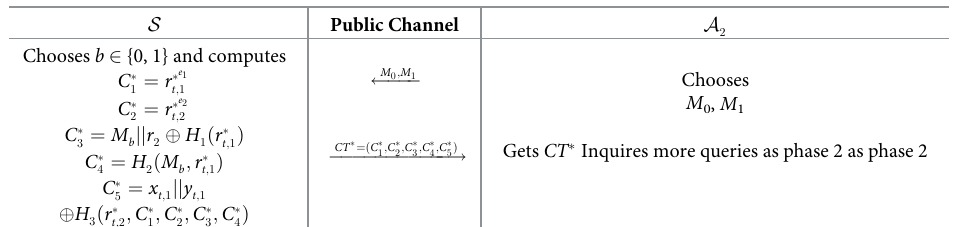
Table 6. Challenge.